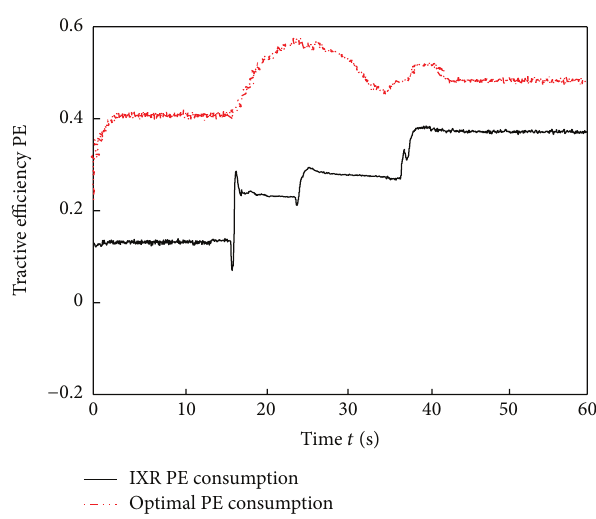
Figure 18: Tractive efficiency comparison of different control